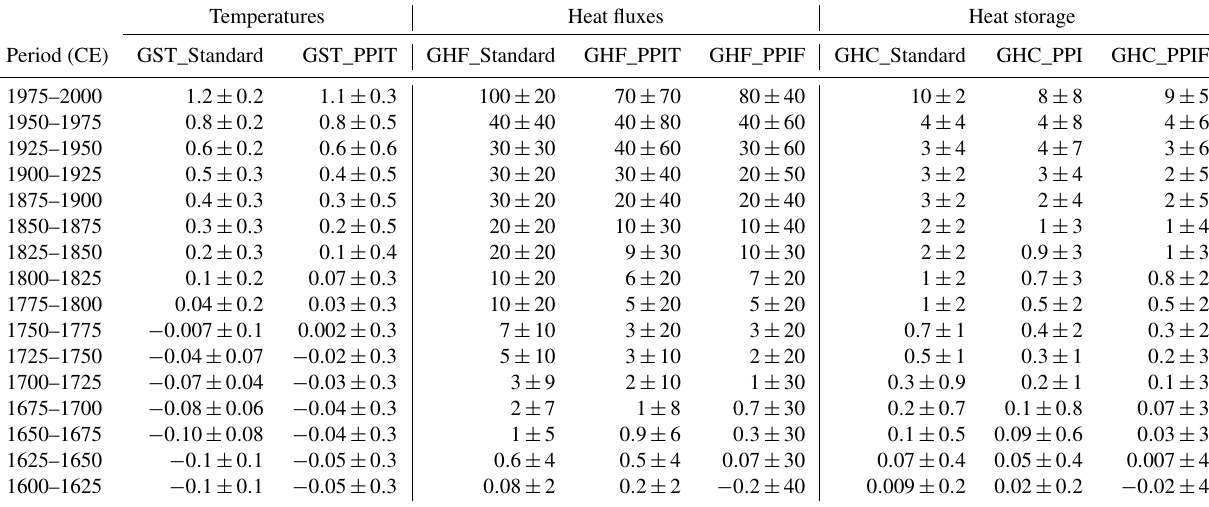
Table 1. Global mean estimates of ground surface temperature (GST), ground heat flux at the surface (GHF), and ground heat content within the continental subsurface (GHC) from borehole temperature profiles. Values display the mean and 95% confidence interval for each time period from estimates using the standard inversion approach (standard) and the new PPI approach applied to temperature and heat flux profiles (PPIT and PPIF, respectively). All the inversions were performed using a model of 25 years per time step (temperatures: K; fluxes: mWm − 2 ; heat content: